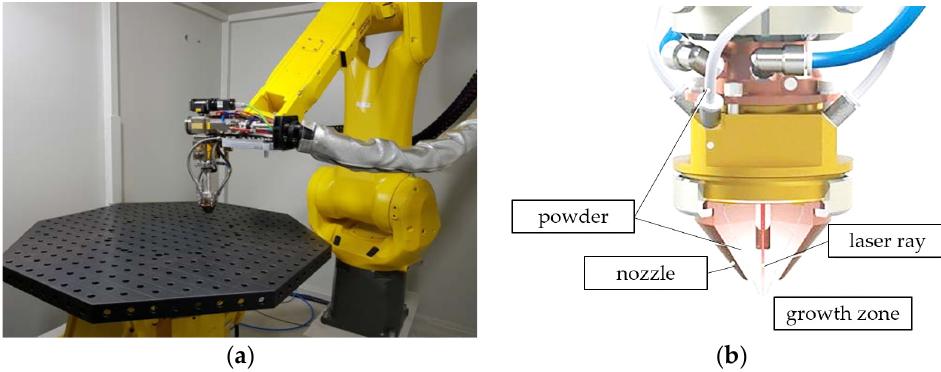
Figure 5. Installation of L-DED based on the FANUC robot: ( a ) installation, ( b ) growing scheme. Table 2. Chemical composition of the powder.